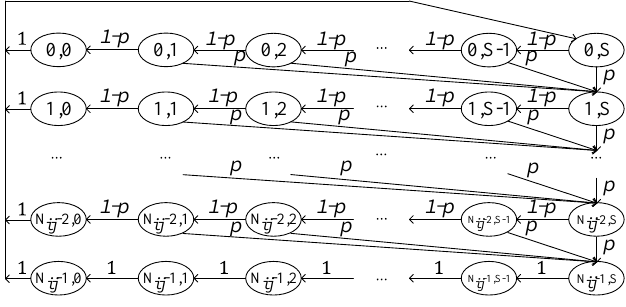
Figure 1. Markov chain